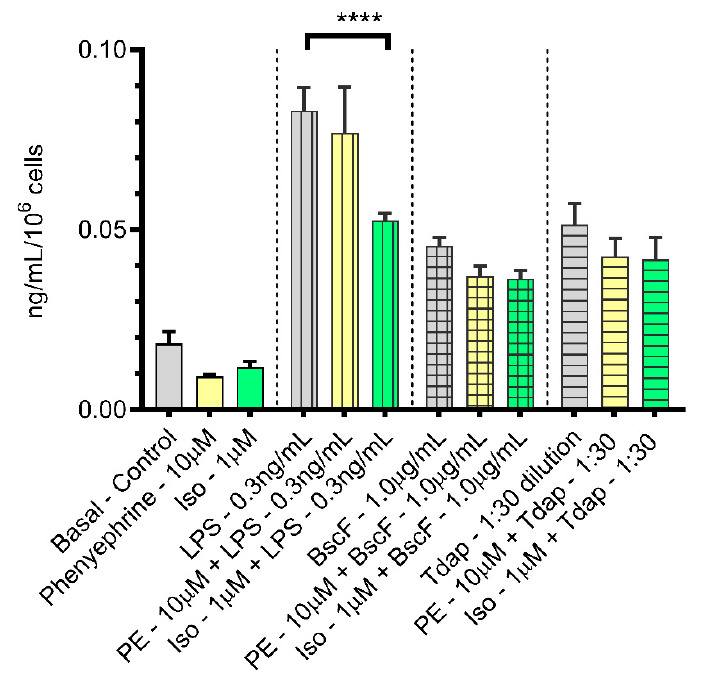
Figure 3. Both PE and ISO failed to significantly attenuate the expression of the prostanoid family member PGE2, upregulated by LPS or B. pertussis antigens, BscF and Tdap, in THP-1 cells. THP-1 cells in serum-deprived RPMI media treated with PBS, PE alone (10.0 µ M), and ISO alone (1.0 µ M) as control treatments, LPS alone (0.3 ng/mL), BscF alone (1.0 µ g/mL), and Tdap alone (1:30 dilution) as antigen stimulation and LPS + PE (0.3 ng/mL + 10.0 µ M)/LPS + ISO (0.3 ng/mL + 1.0 µ M), BscF + PE (1.0 µ g/mL + 10.0 µ M)/BscF + ISO (1.0 µ g/mL + 1.0 µ M), and Tdap + PE (1:30 dilution +10.0 µ M)/Tdap + ISO (1:30 dilution +1.0 µ M) as agonist treatment groups. Twenty-four hours later, conditioned media from both the control, antigen stimulation, and agonist treatment groups were collected, and prostanoid levels were quantitated with UPLC–MS/MS. The difference in PGE2 level between antigen stimulation and agonist treatment groups is shown as mean ± SEM. of triplicate assays. ∗∗∗∗ p < 0.0001 indicates a statistically significant difference when compared with antigen stimulation alone.